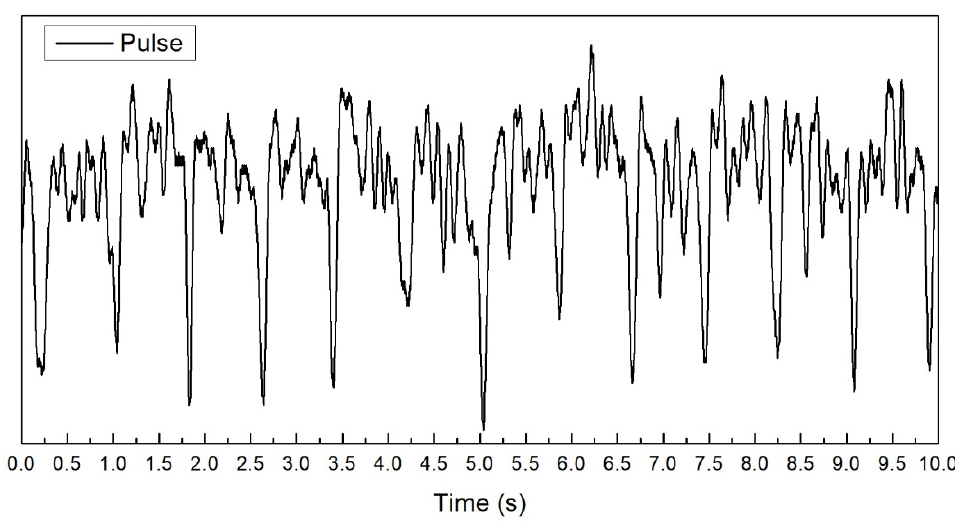
Figure 9. The human pulse waveform captured by sample PT10Zad.